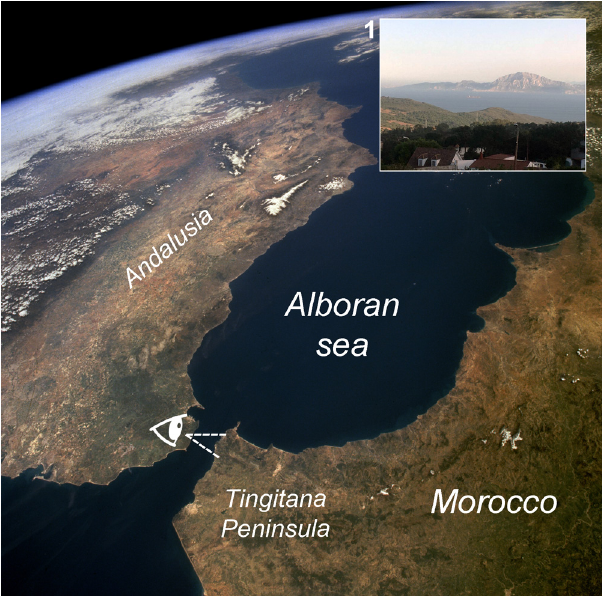
Figure 1: Satellite view of the Strait of Gibraltar in the geographical framing of southern Iberia and Northern Morocco. NASA archives. ( 1 ) in the upper - right angle, detail of African shore ( Jebel Musa ) from Andalusian ( Tarifa ) territory ( 2020, RMMS )